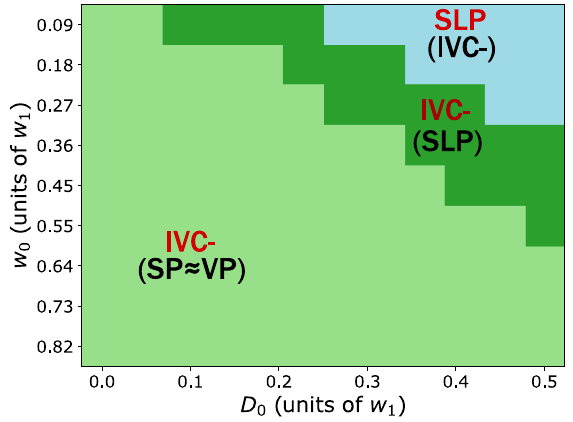
FIG. 4. Phases obtained by self-consistent HF method as a function of w 0 and D 0 . Both the leading instability (red) and the subleading ones (black, in parentheses) are shown. The phases are identified by the symmetries they break (see Table II), and representative band structures can be found in Fig. 3. We show only one state as a representative of each pair of Hund ’ s partners which are degenerate in our Hartree-Fock procedure. We label the nearly degenerate SLP , SLP − , SSLP , and SSLP − phases with þ þ “ SLP, ” though note the preference in our numerics is for the SLP − state from a Hartree